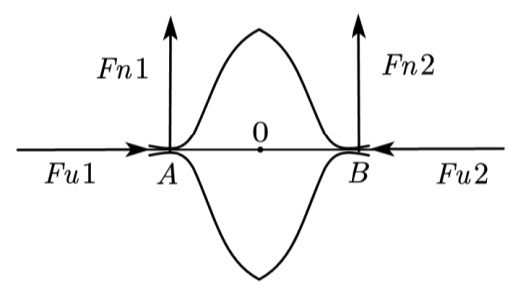
Figure 13. Mechanical sketch of net sleeve extrusion clamping.